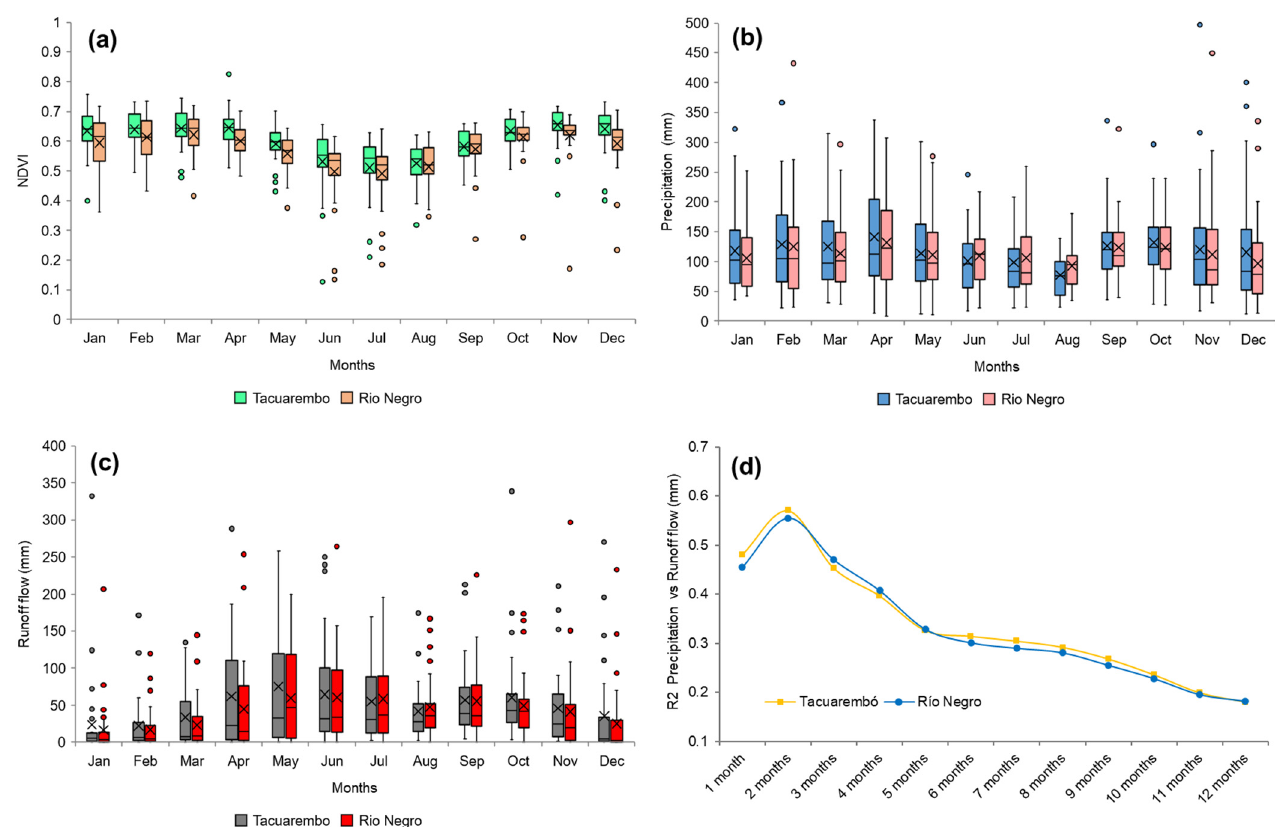
Figure 3. Analysis of the annual profile of the NDVI index and precipitation for the period 1984–2014. ( a ) Box and whisker plot of the monthly average of the NDVI index. Green boxes correspond to the Tacuaremb ó basin and orange boxes to the R í o Negro basin. ( b ) Accumulated average monthly precipitation. Boxes in blue correspond to the Tacuaremb ó basin and boxes in red correspond to the R í o Negro basin. ( c ) The monthly average runoff flow is expressed in mm. Boxes in lead correspond to the Tacuaremb ó basin and in red, to the R í o Negro basin. The boxes represent the interquartile range, the bars represent the maximum and minimum values, the intermediate “X” identifies average values and the outer points correspond to the outlier. ( d ) Variation analysis of the coefficient of determination between accumulated precipitation and runoff flow. The runoff flow was considered for a single month and the precipitation gradually accumulated month by month.